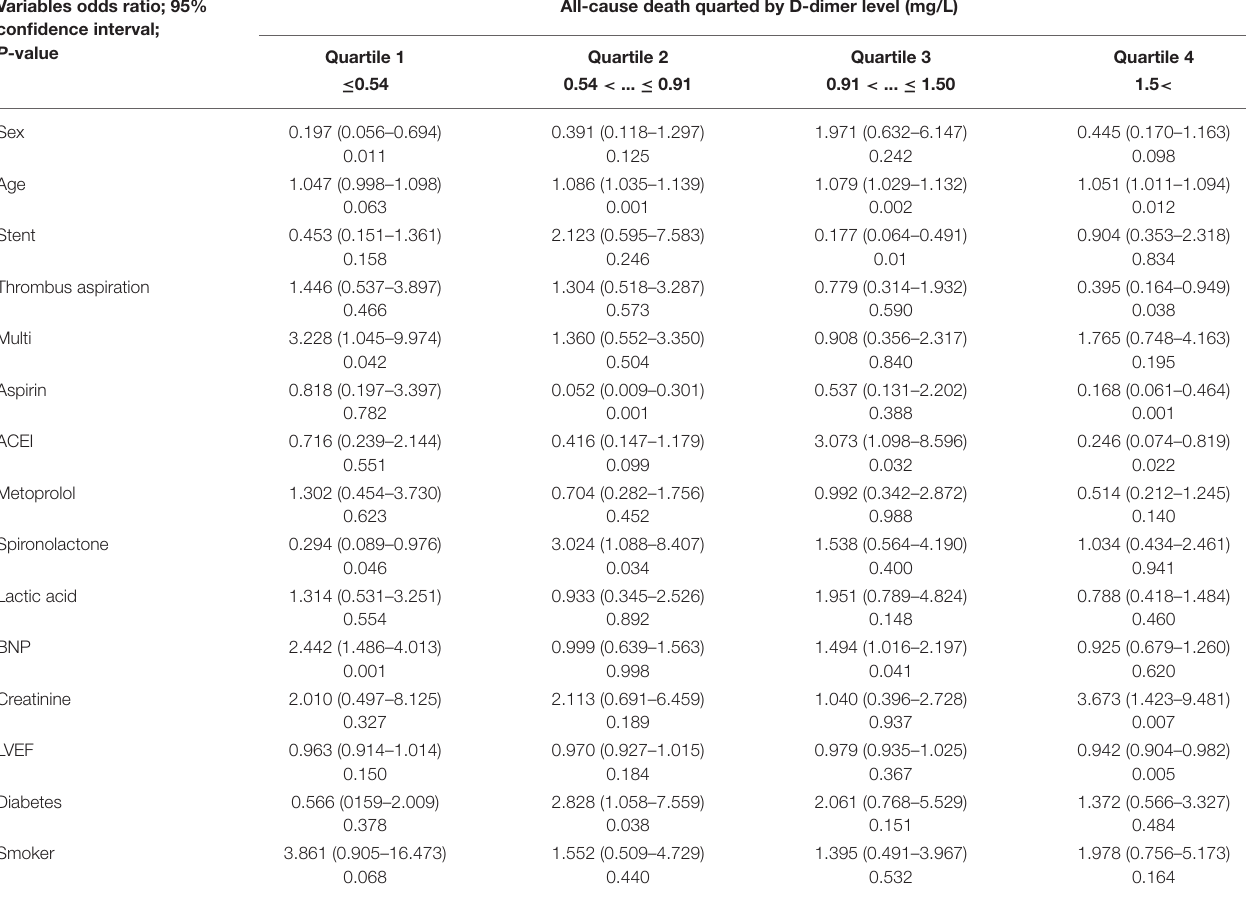
TABLE 6 | Multivariable logistic regression analyses according to quartile of D-dimer levels. Variables odds ratio; 95% confidence